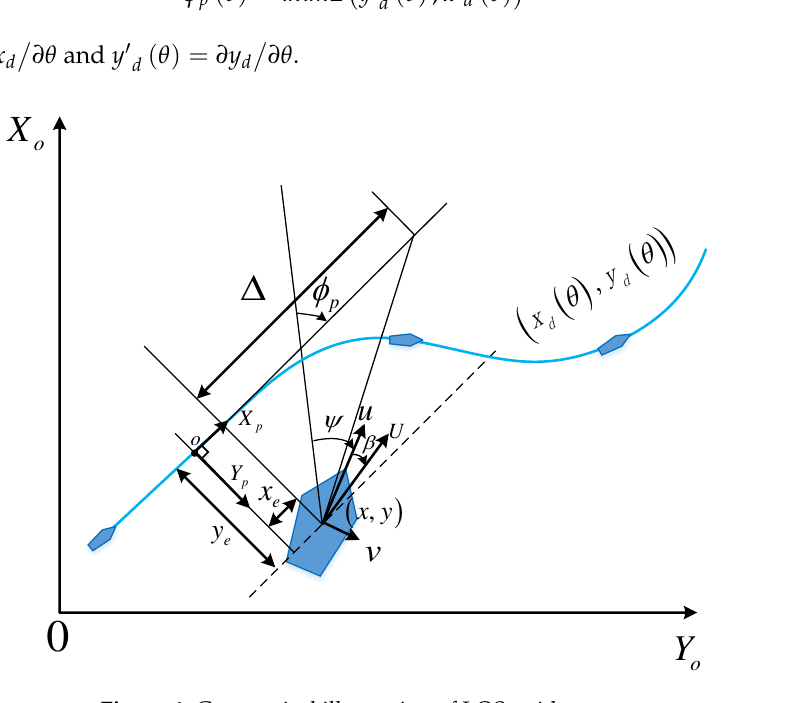
Figure 4. Geometrical illustration of LOS